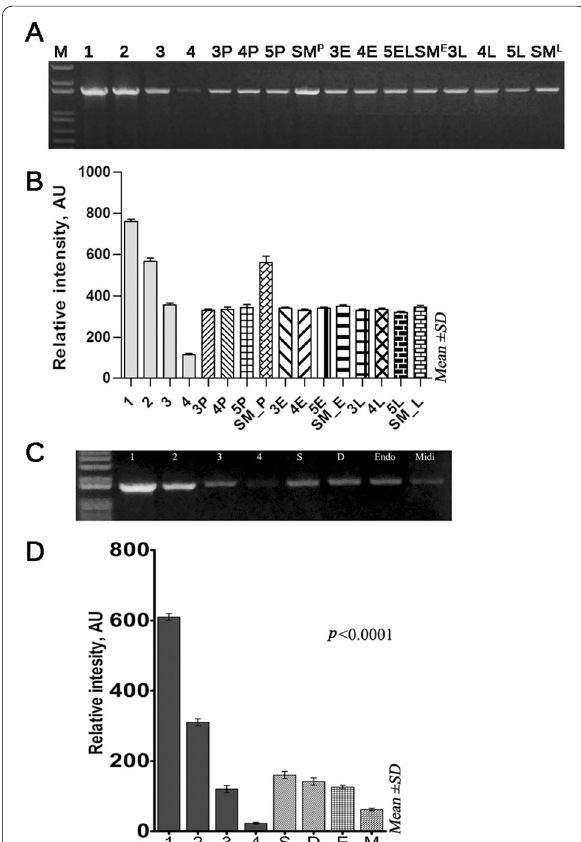
Fig. 4 DM minipreps plasmids have a lower amount of host genomic